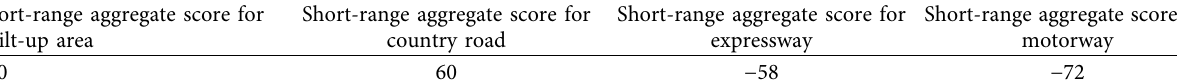
Table 6: Aggregated short-range scores computed from the scores appearing in Table